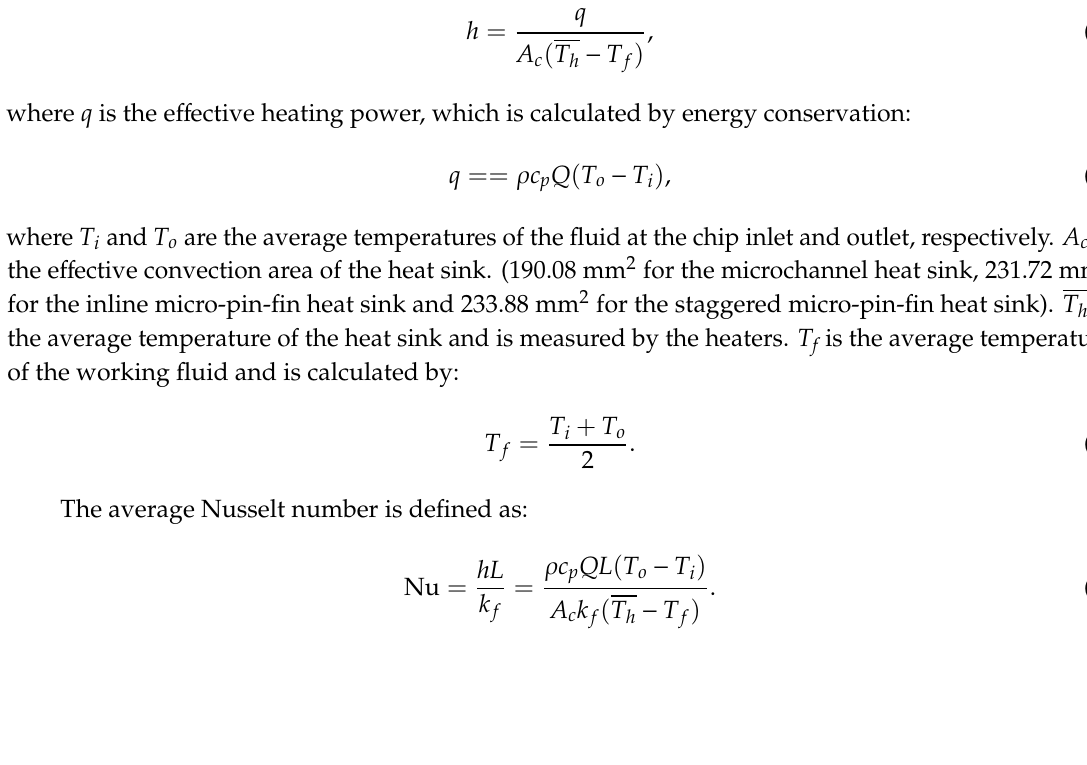
Figure 4. Scanning electron microscopy (SEM) photos of ( a ) the microchannel and ( b ) the micro pin fin.